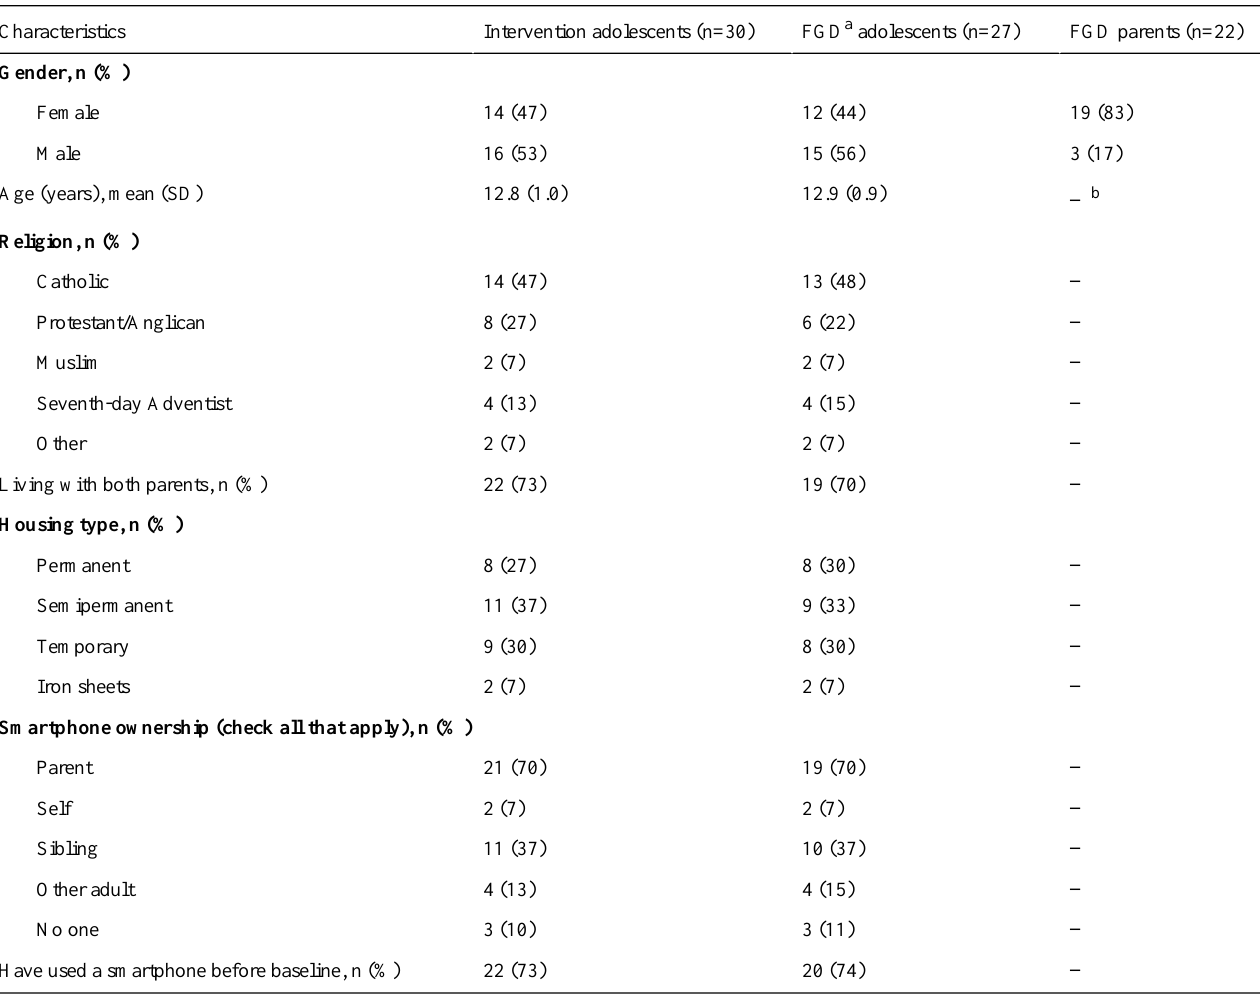
Table 1. Participant